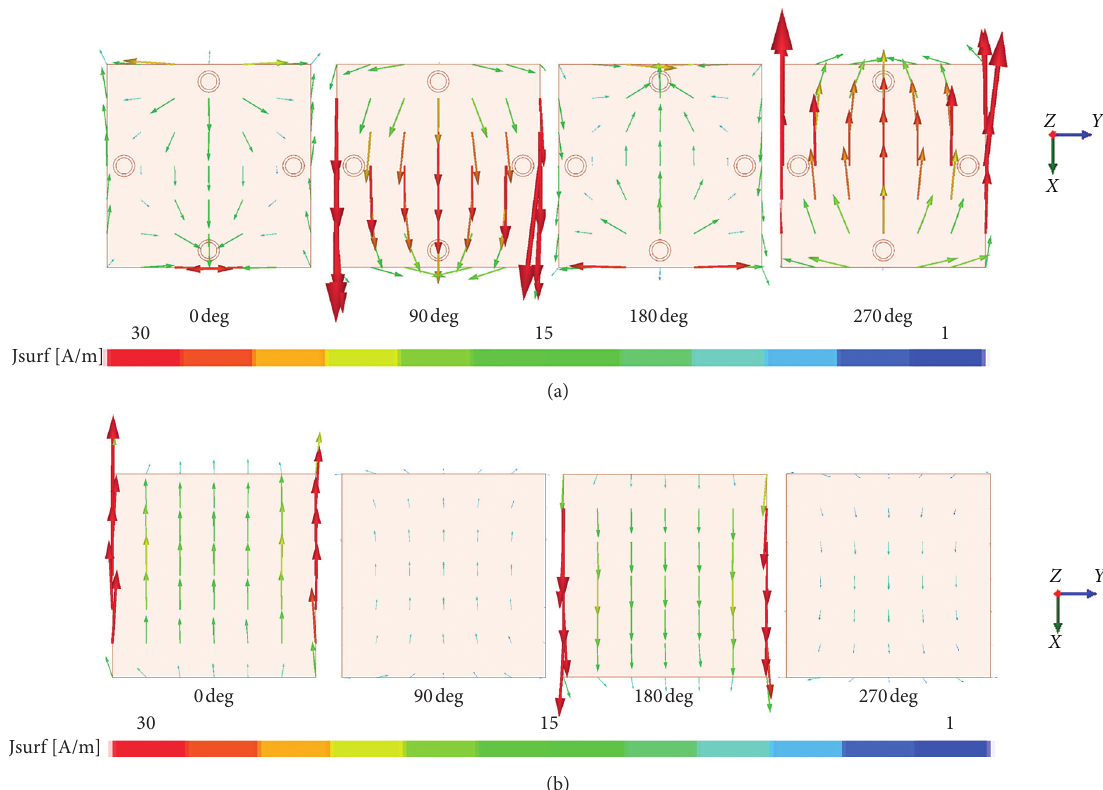
Figure 6: Current distributions on the main patch and the parasitic patch when port A is fed differentially: (a) main patch and (b) parasitic